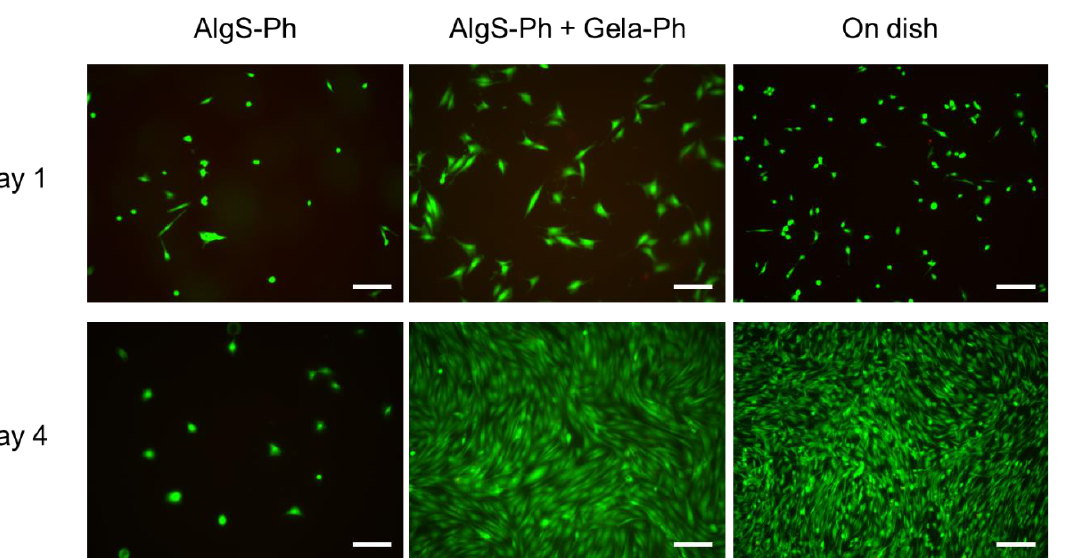
Figure 4. Merged micrographs of 10T1/2 cells cultured on hydrogels consisting of AlgS-Ph alone or AlgS-Ph and Gela-Ph together. Live and dead cells were stained with Calcein-AM/PI (green/red), respectively. Scale bars: 200 µm.